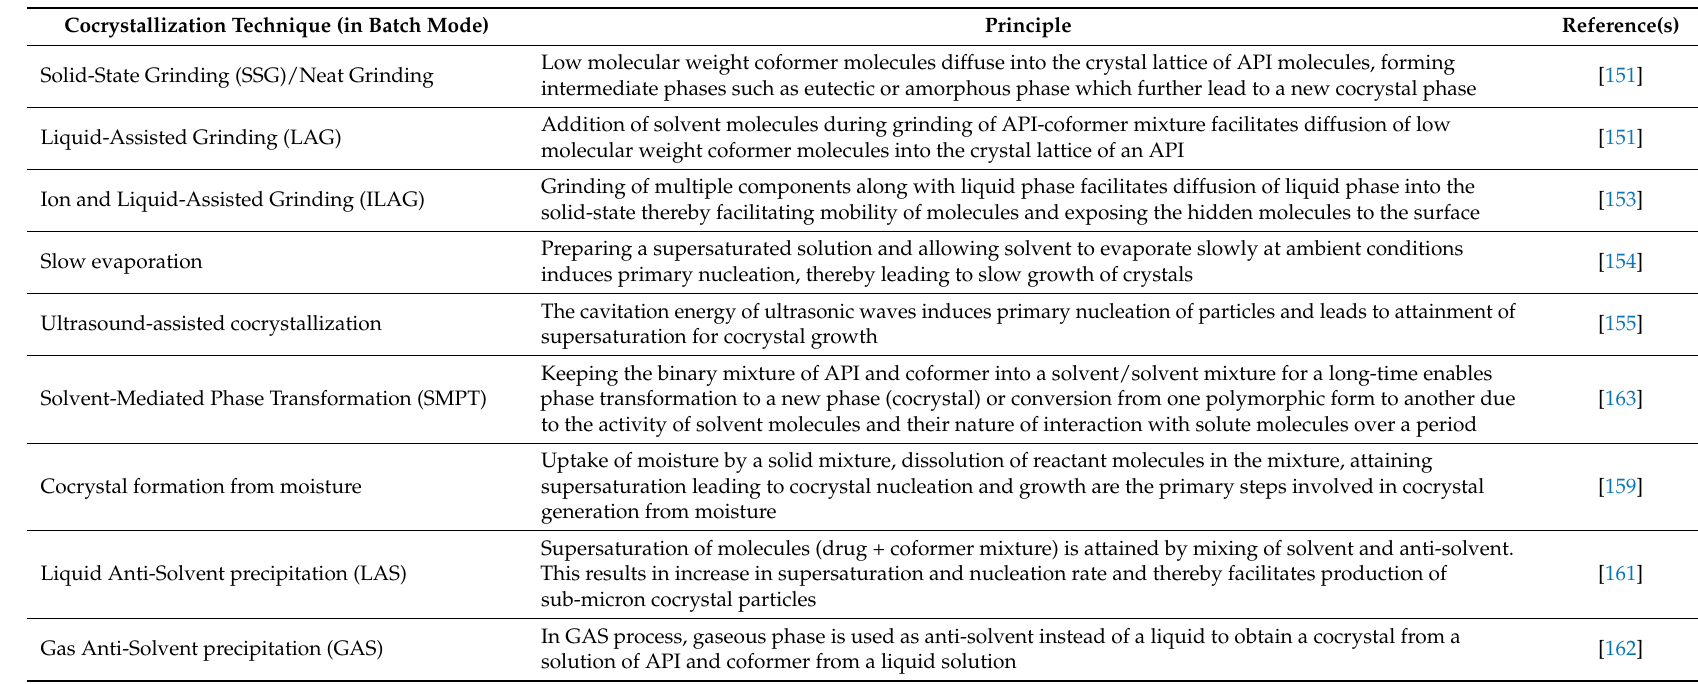
Table 7. Summary of batch processes used for cocrystal